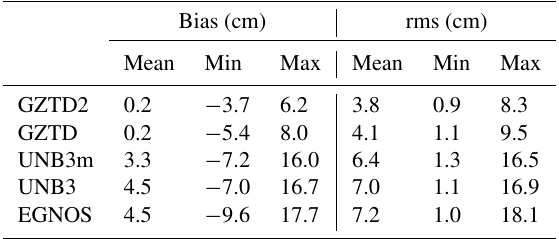
Table 2. Modeling errors of different models validated by GGOS data.